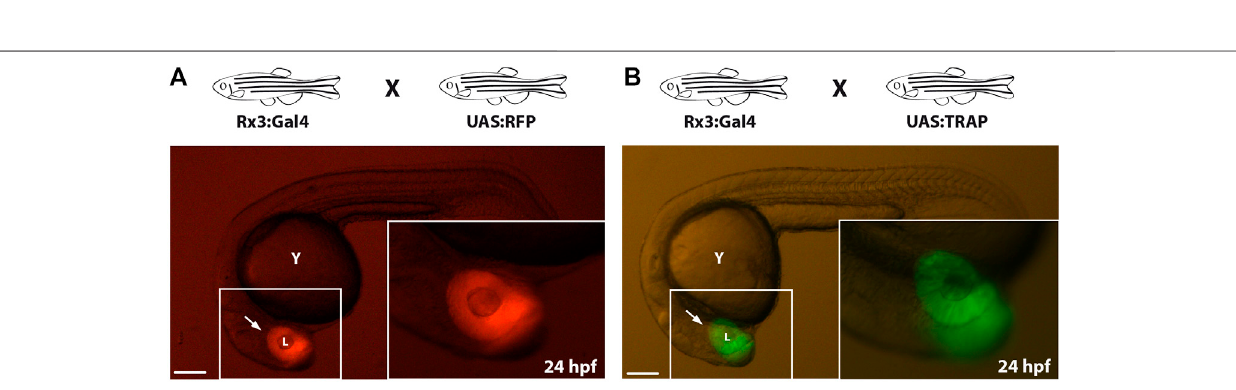
FIGURE4| Compatibility ofTRAP technology withthe Gal4/UAS system: (A) : Zebra fi sh embryo from thecontrolcross Tg[Rx3:Gal4] x Tg[UAS:RFP] showingRFP expression in the developing retina (arrow) at 24 hpf. (B) : zebra fi sh embryo derived from a Tg[Rx3:Gal4] × Tg[UAS:TRAP] cross showing eGFP-rpl10a expression at 24 hpf in the retina (arrow). l, lens; y, yolk. Scale bar (cid:1) 100 µm.